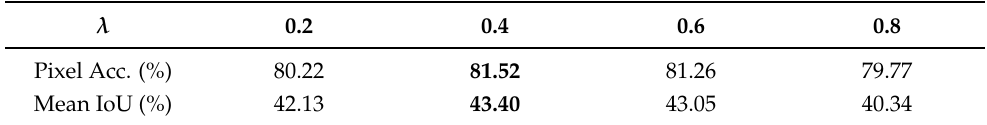
Table 4. The performance of our model using different λ . λ 0.2 Pixel Acc.